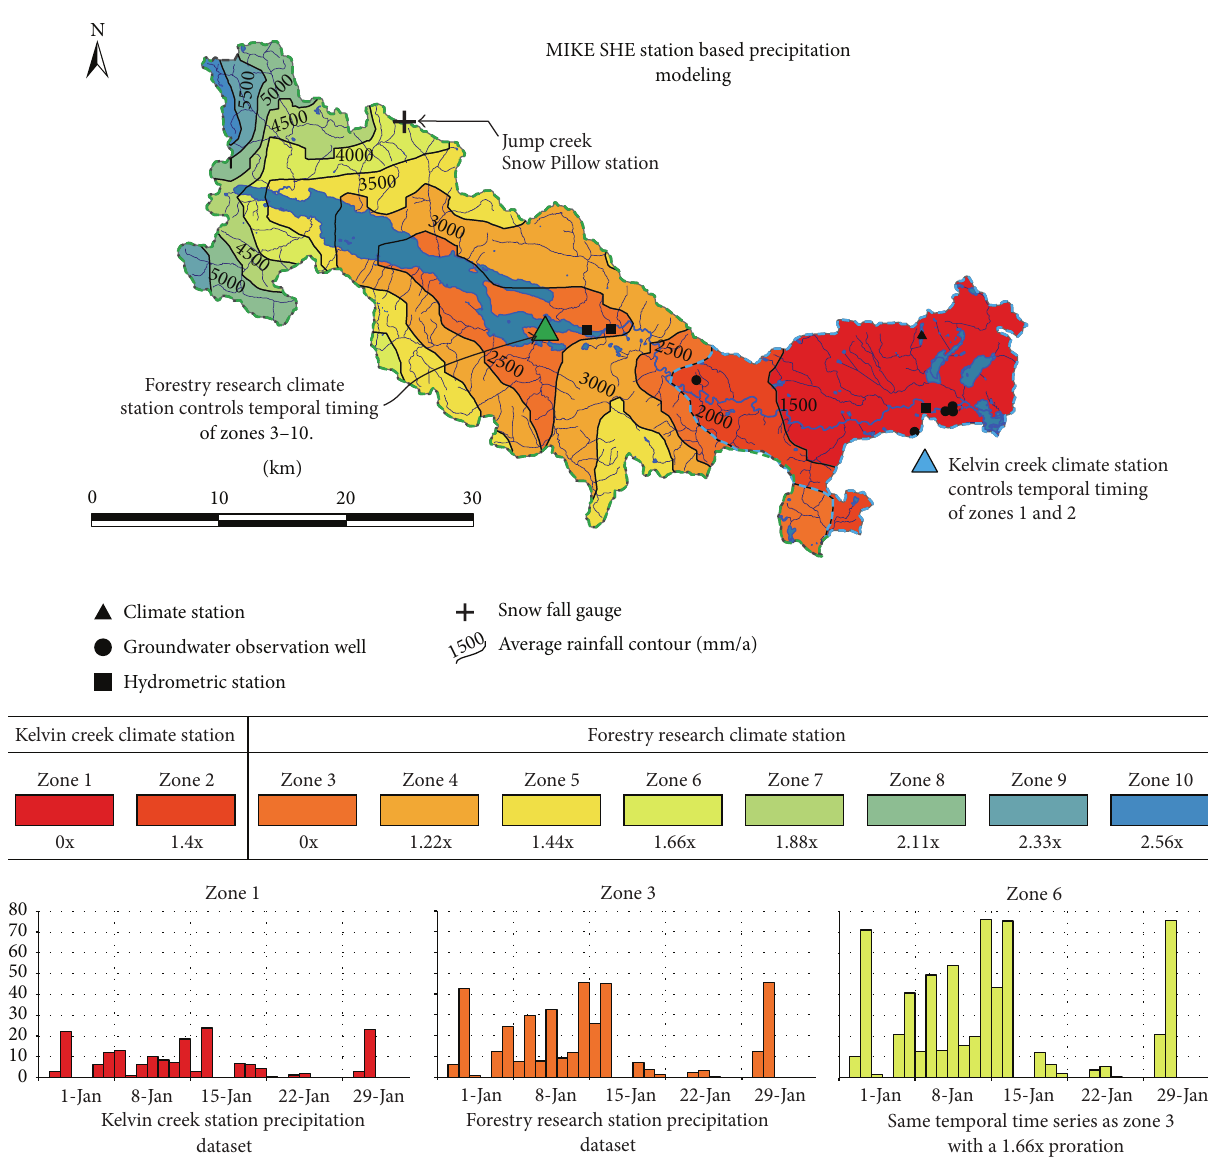
Figure 3: Method of applying meteorological data across the watershed to the MIKE SHE